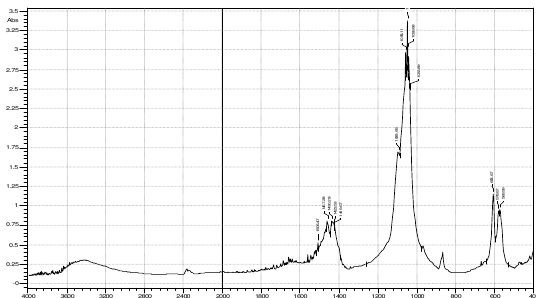
Fig. 3. FTIR Spectra of raw Akashat phosphate Ore size 300 micron.